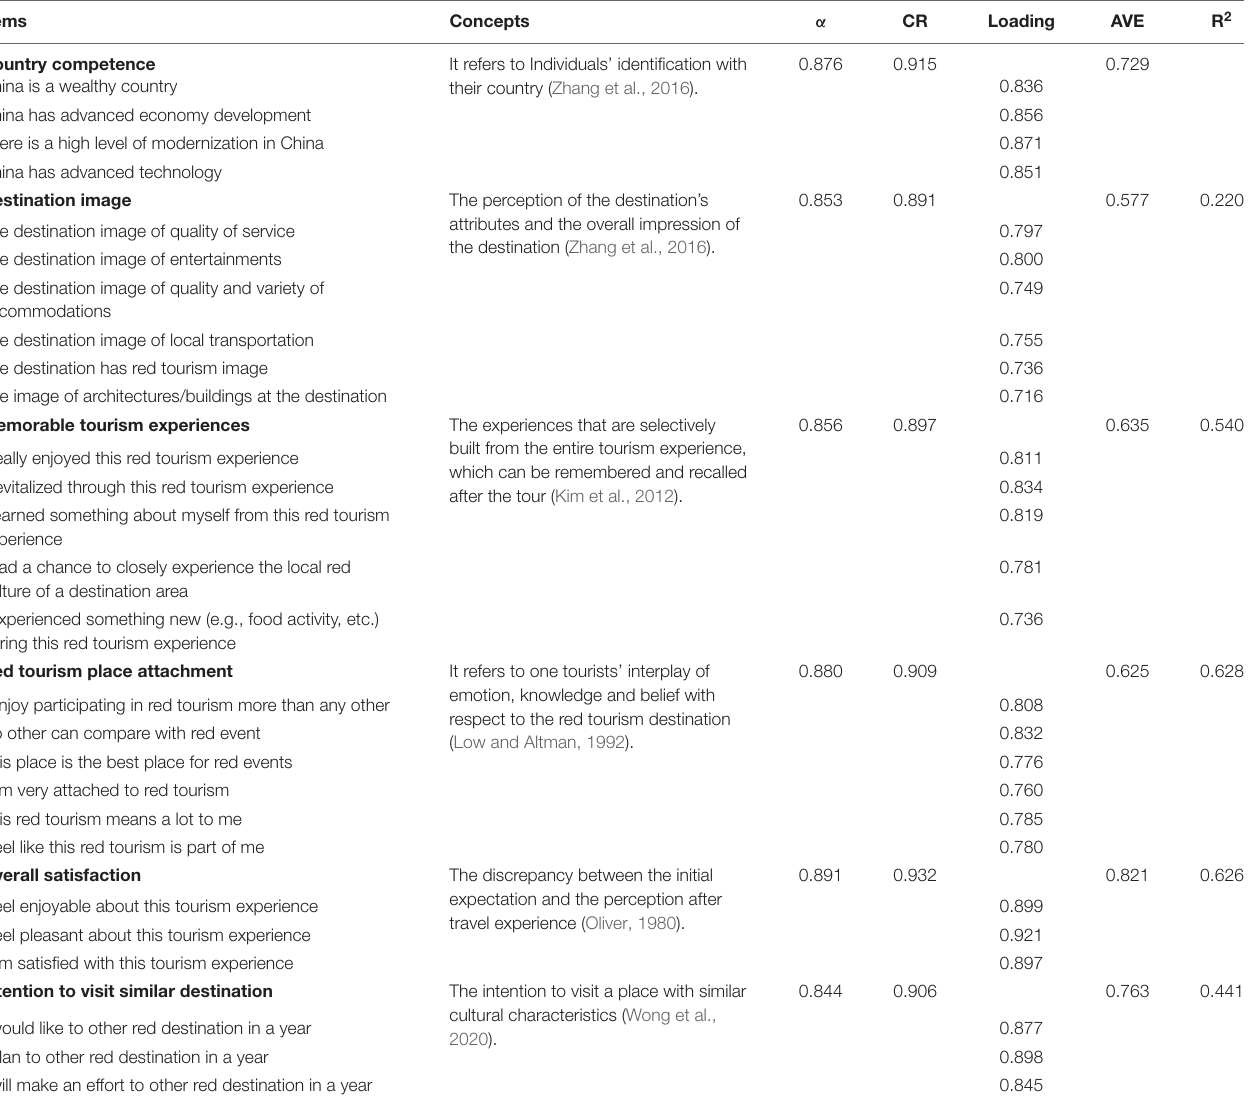
TABLE 1 | Assessment of the measurement model and descriptive